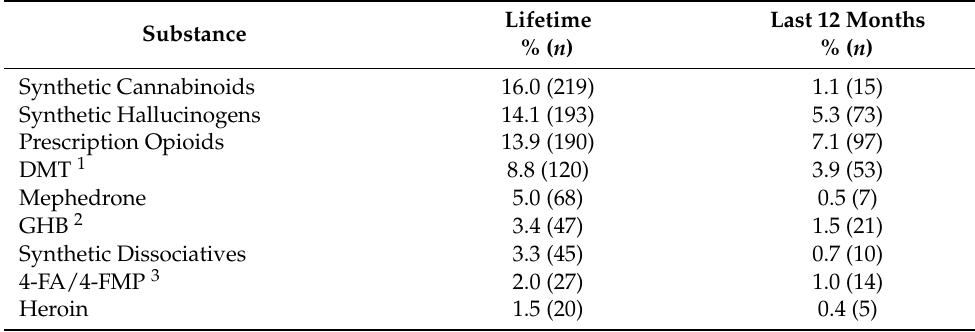
Table 2. Prevalence of illicit drugs less commonly used ( n = 1371).